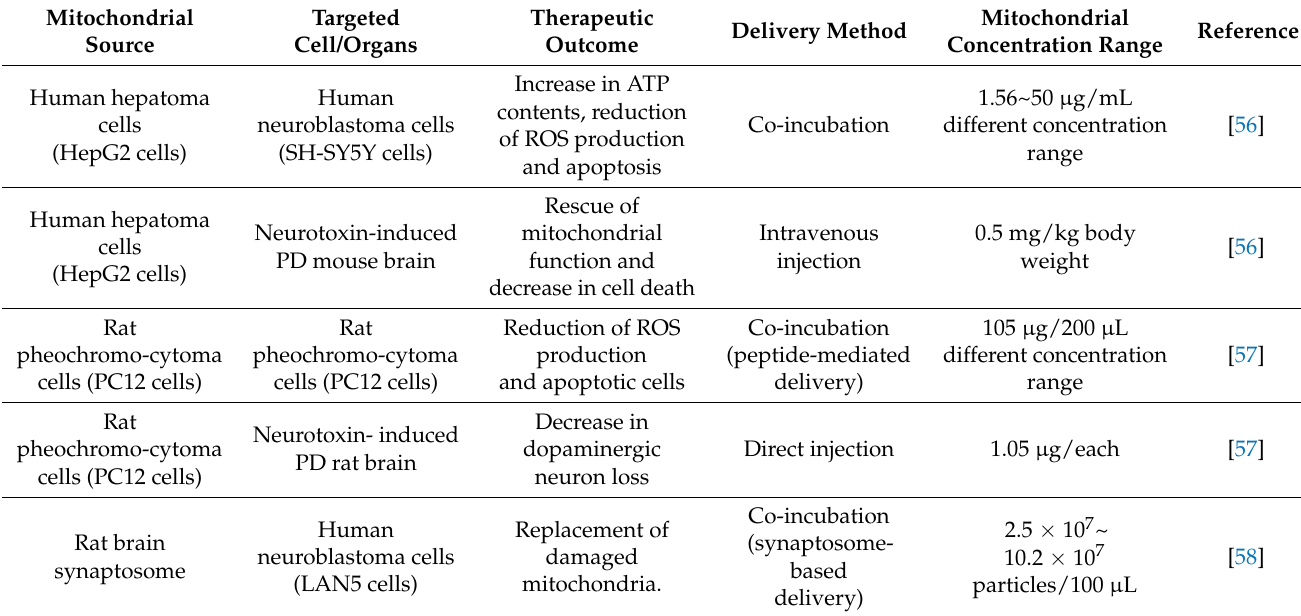
Table 1. Research reports of mitochondrial internalization in neurological